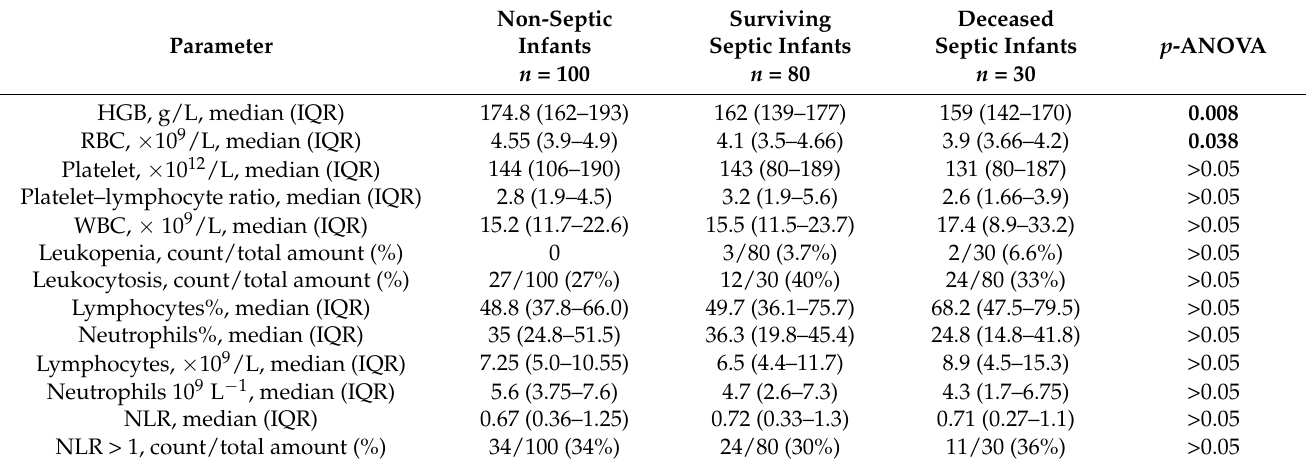
Table 3. The main indicators of the hemogram. Venous blood was analyzed by a hematological analyzer in three